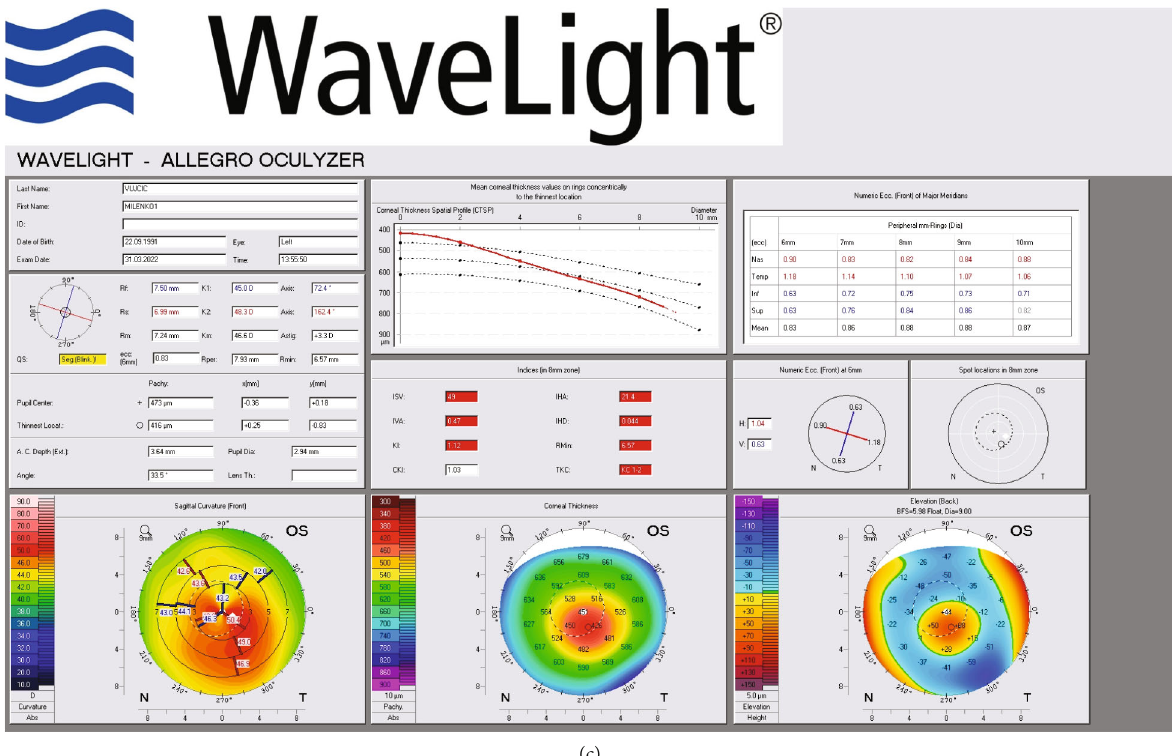
Figure 1: Oculyzer image of the left eye before and after DISC ablation and corneal crosslinking radiating with UV-A at 3mW/cm 2 . (a) Oculyzer image of the patient ’ s left eye before surgical procedure. (b) Oculyzer image of the patient ’ s left eye two months after surgical procedure. (c) Oculyzer image of the patient ’ s left eye seventeen months after surgical procedure.